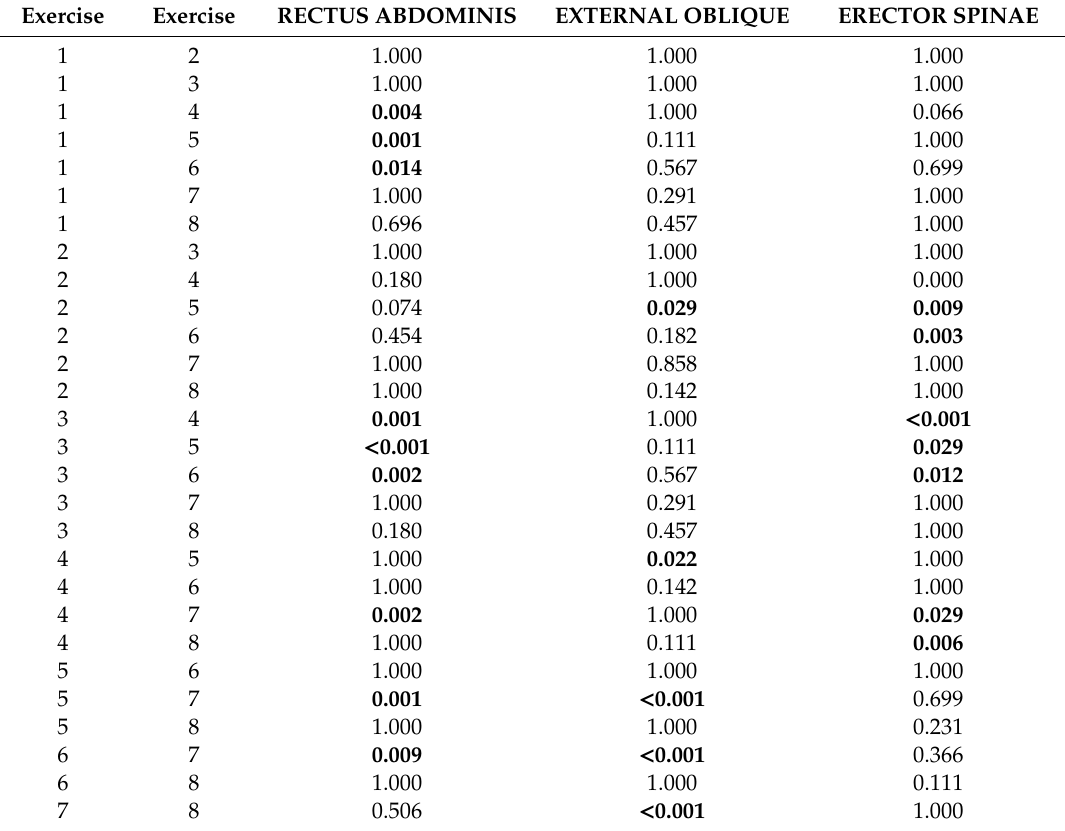
Figure 2. EMG during 8 of the 9 exercises (i.e., the lateral plank was not included due to its general non-tolerability). Circles show individual data. Numbers between parentheses denote statistical differences between the exercises (e.g., number 1 means different from the exercise number 1, which is the torso-twist). Table 1. P-values of post-hoc comparison between muscle activity of each exercise in the individual muscles.